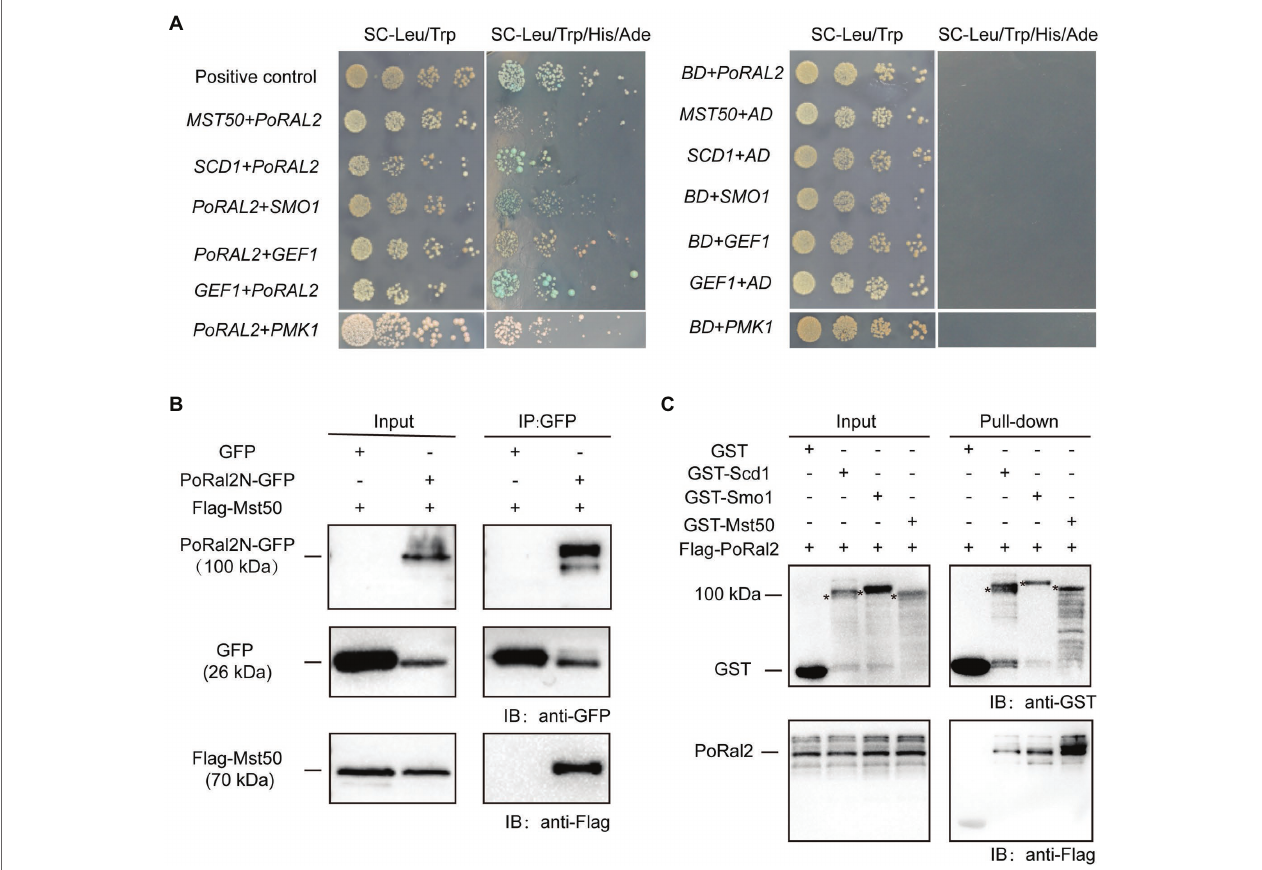
FIGURE 7 | Protein interactions assays. (A) Yeast Two-Hybrid Assays. PoRal2 and Smo1, Pmk1, Gef1, Scd1 or Mst50 cloned in pGADT7 or pGBKT7 were co- transformed into yeast and cultured on selection media. (B) Co-immunoprecipitation results of PoRal2N-GFP and Mst50-3 × Flag in P. oryzae . PoRal2N-GFP and Mst50-3 × Flag was detected in PoRal2N-GFP elution buffer, while only GFP was detected in GFP elution buffer. (C) Pull-down results of 3 × Flag-PoRal2 between GST, GST-Scd1, GST-Smo1, and GST-Mst50 in E. coli BL21. 3 × Flag-PoRal2 was detected in GST-Scd1, GST-Smo1 and GST-Mst50, but not in GST alone elution buffer. Asterisks represented the band of Scd1 (141.82 kDa), Smo1 (141.82 kDa), or Mst50 (80.34 kDa),